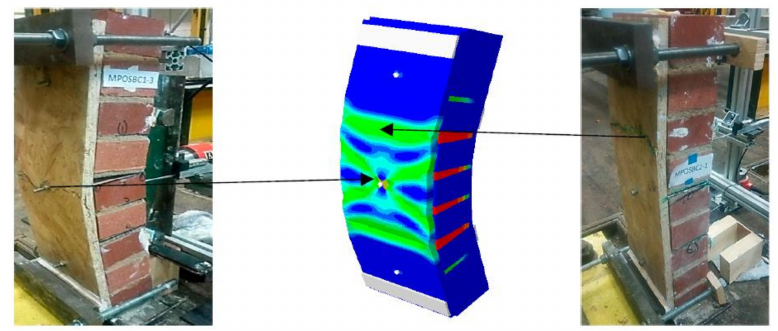
Figure 16. Failure pattern of MPOSB (experimental and FE model).